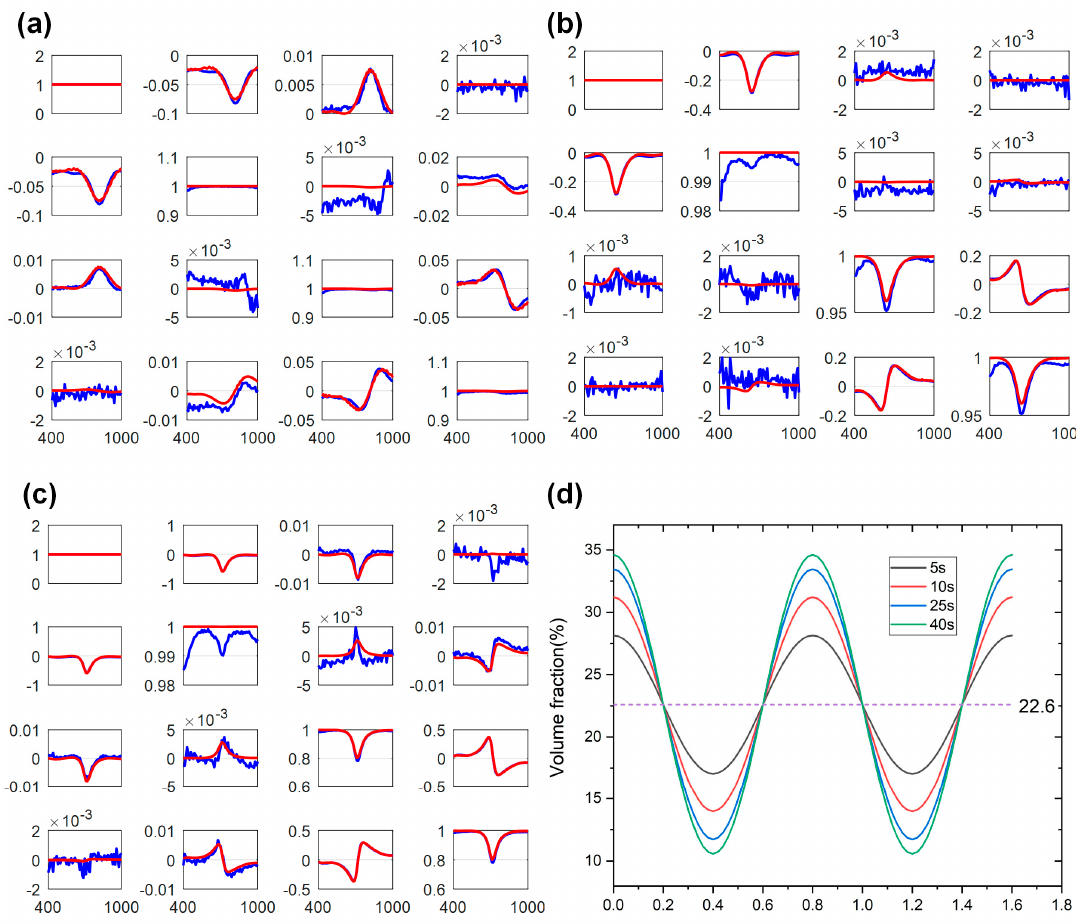
Figure 6. Results of calculated (red) and measured (blue) Mueller matrix spectra in the transmission mode when recording time ( a ) t = 5s; ( b ) t = 10s; ( c ) t = 40s; and ( d ) measured spatial refractive index distribution curve of a volume grating at different exposure time. Table 4. Measured results of volume gratings with different exposure time.